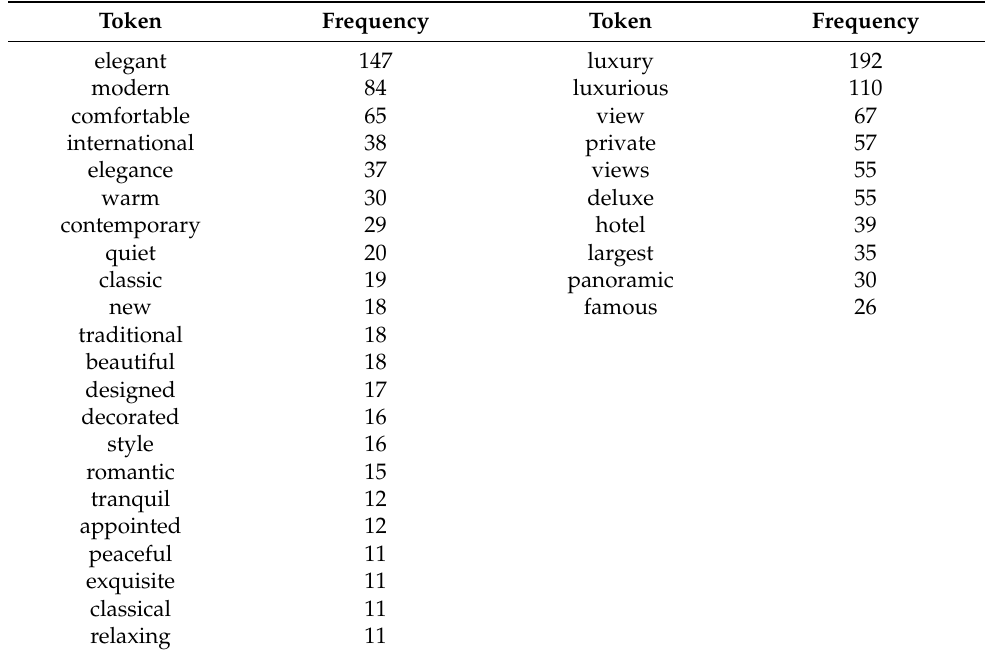
Table 2. Expressions in ambience and prestige.